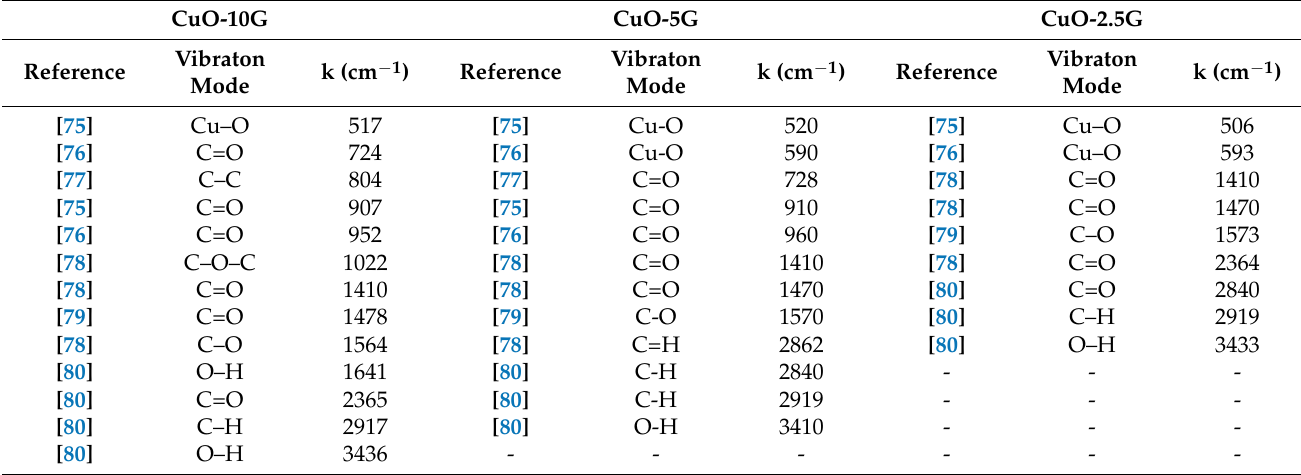
Table 6. Bond assignments of CuO-2.5G, CuO-5G and CuO-10G nanocomposites in FTIR spectra.